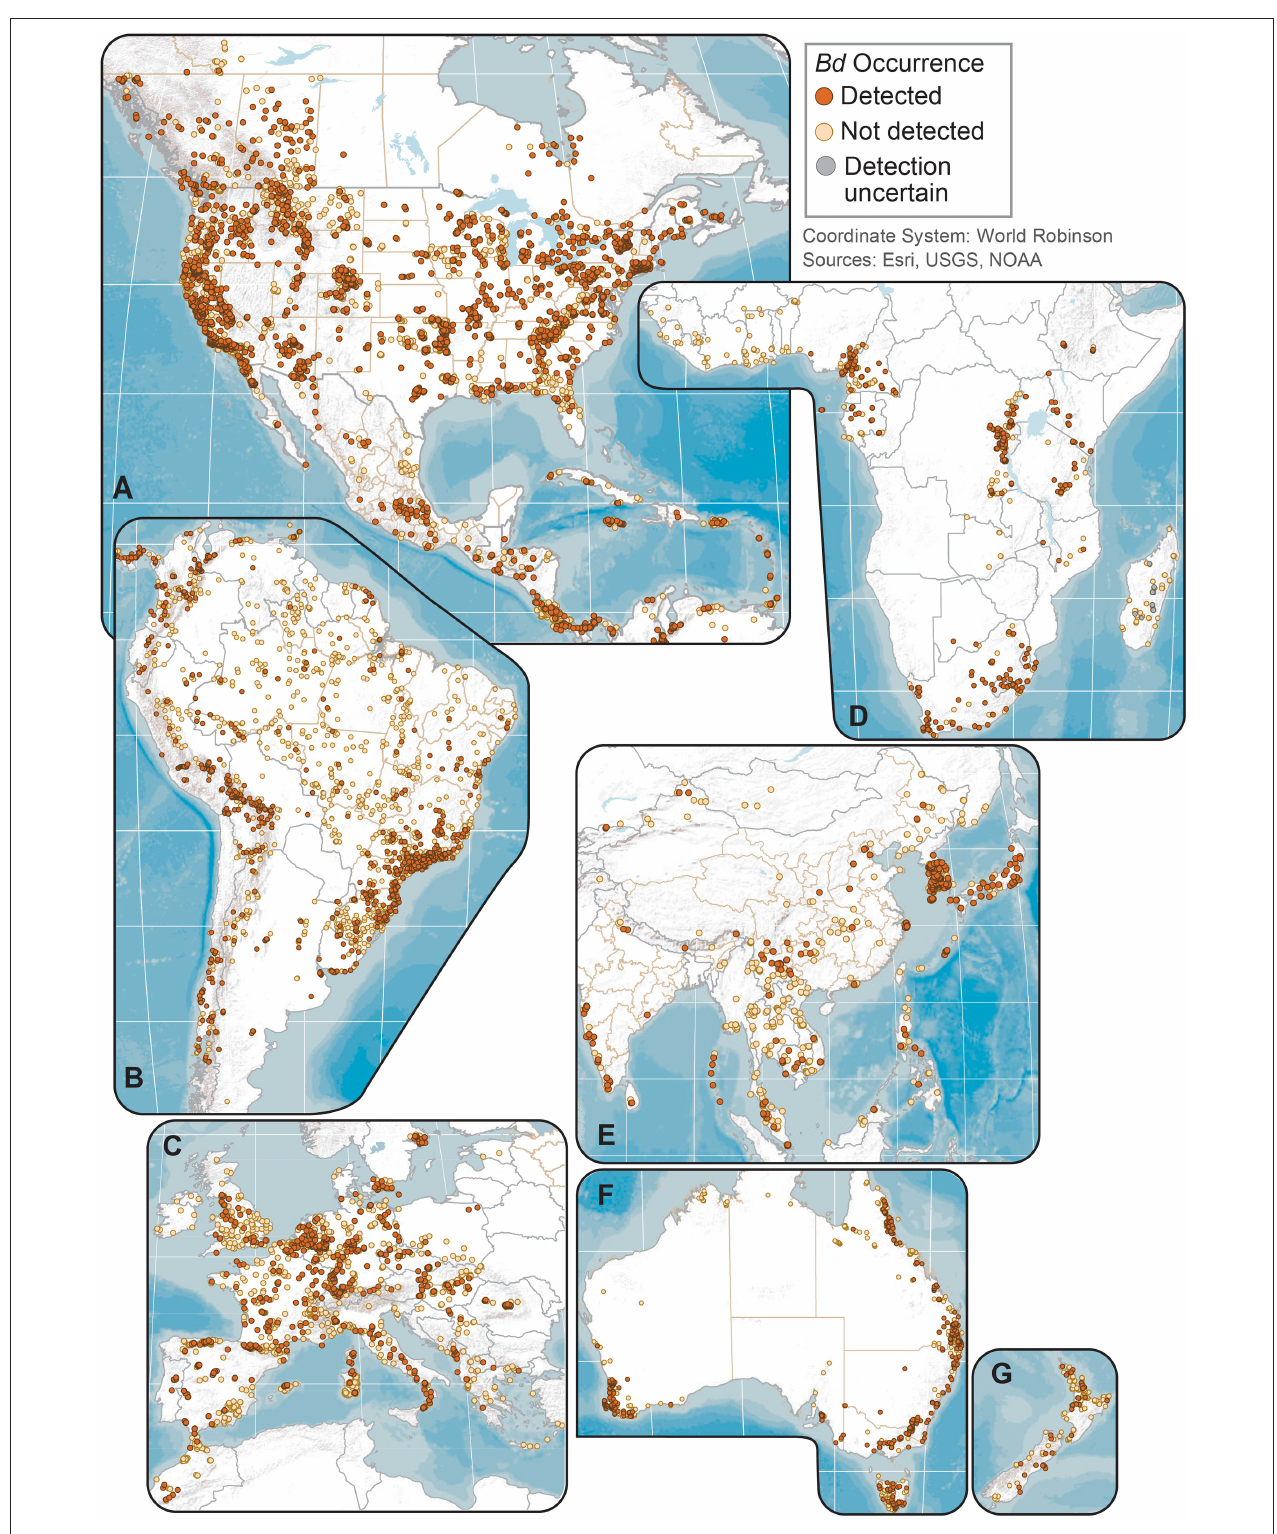
FIGURE 2 | Regional maps of Batrachochytrium dendrobatidis ( Bd ) occurrences at unique sites from data compiled for the Global Bd Mapping project: (A) North America; (B) South America; (C) Europe; (D) Africa; (E) Eastern Asia; (F) Australia; and (G) New Zealand. Sites shown with Bd detections also may have sampling results with no detection; records with only country-level coordinates are not